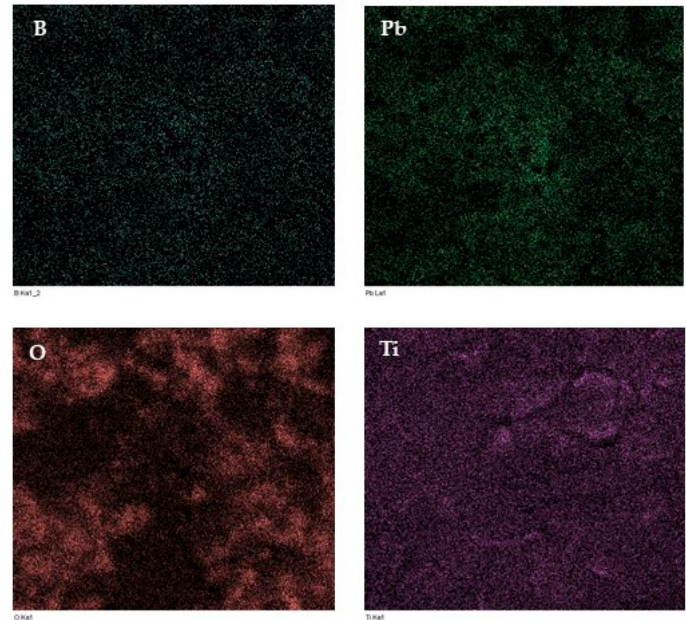
Figure 5. EDX images of SS/TiO 2 /PbO 2 -10%B electrode in top